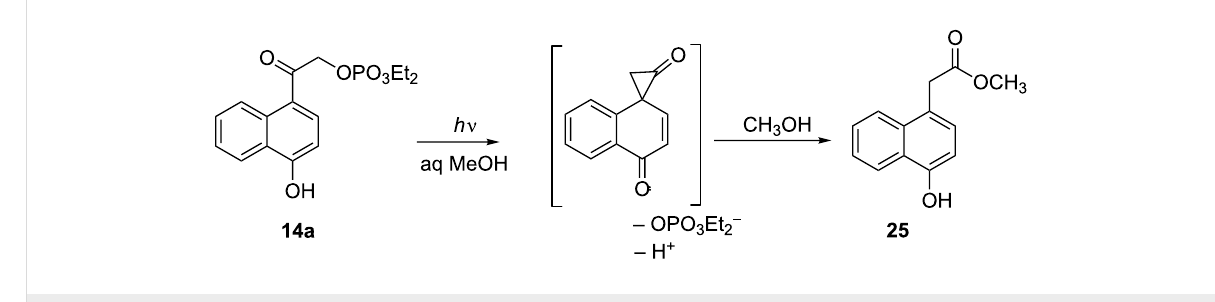
Scheme 4: The photo-Favorskii rearrangement of 14a .